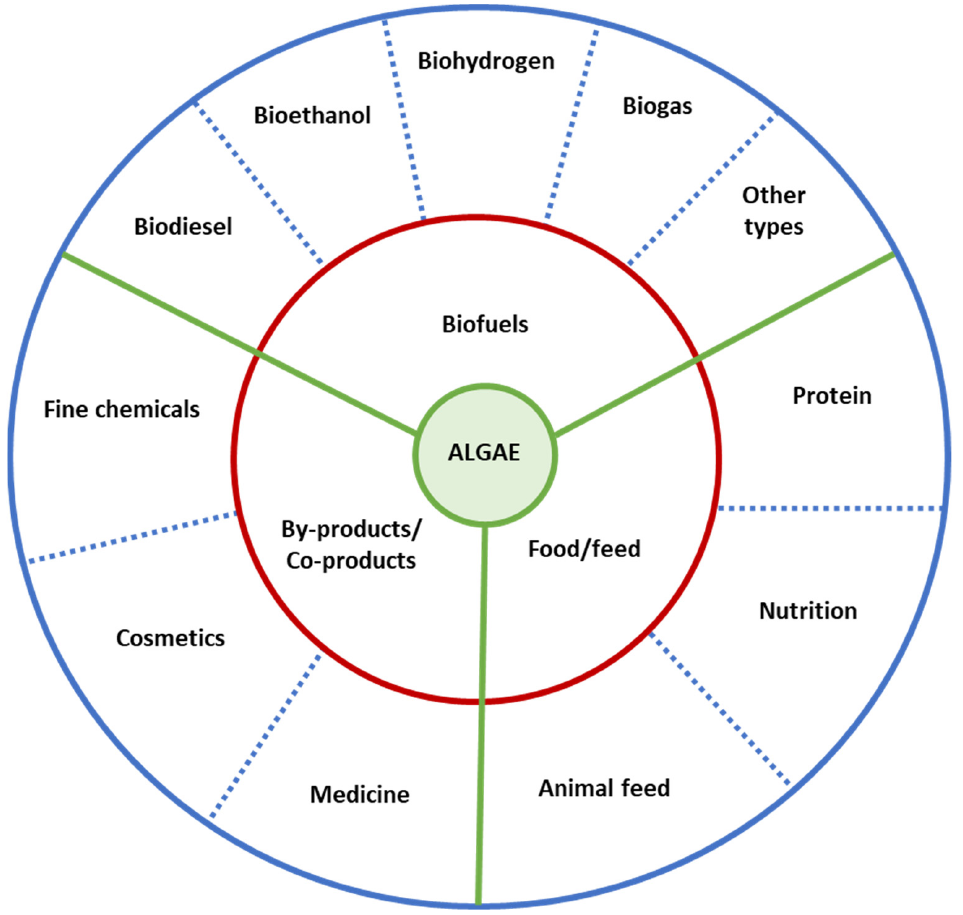
Figure 1. Array of product fields obtained from an algae biorefinery. Adapted with permission from the work of Zhu [21], published by Elsevier, 2015.